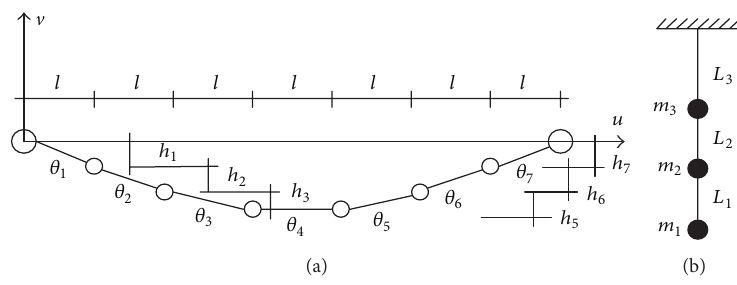
Figure 1: MDOF elastic model of a transmission line. (a) In-plane vibration. (b) Out-of-plane